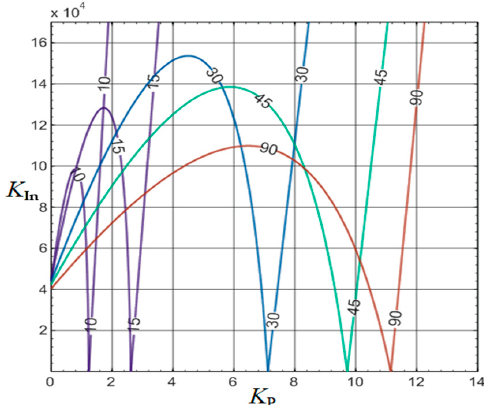
Figure 11. Evaluation of the stability region in the k P - k In plane, for the nominal case.